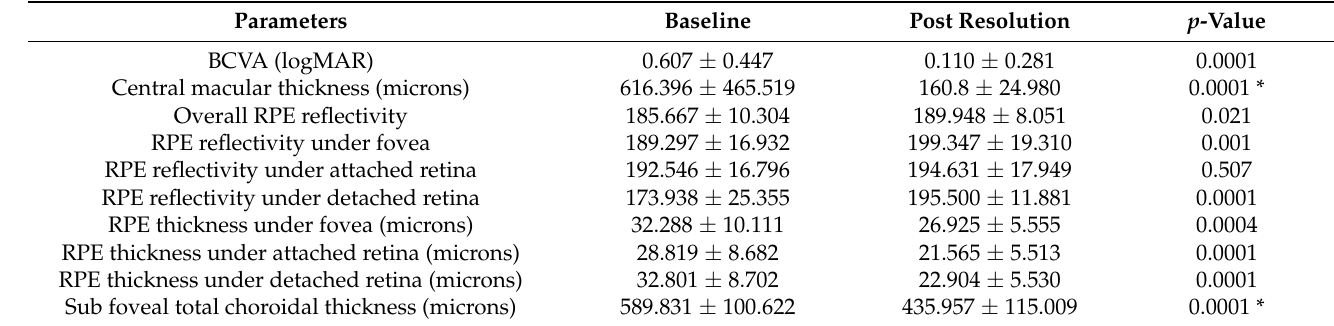
Table 1. Comparison of parameters during the acute stage of the disease and following resolution of disease